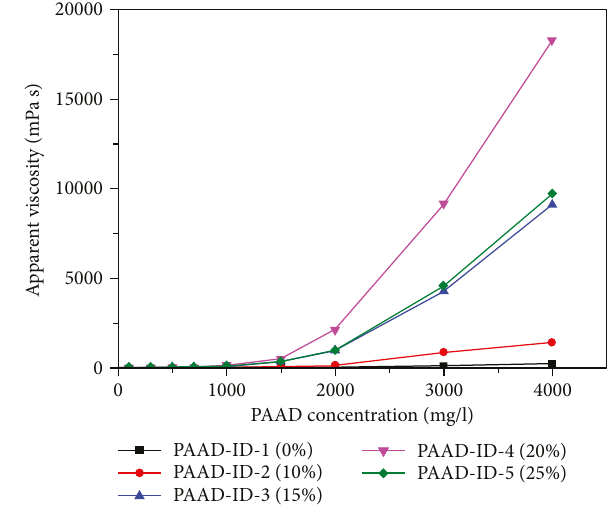
Figure 4: Variation of the apparent viscosity with concentration of PAAD at the shear rate of 0.6s − 1 in water with the NaCl concentration of 1000mg/l at 25 °